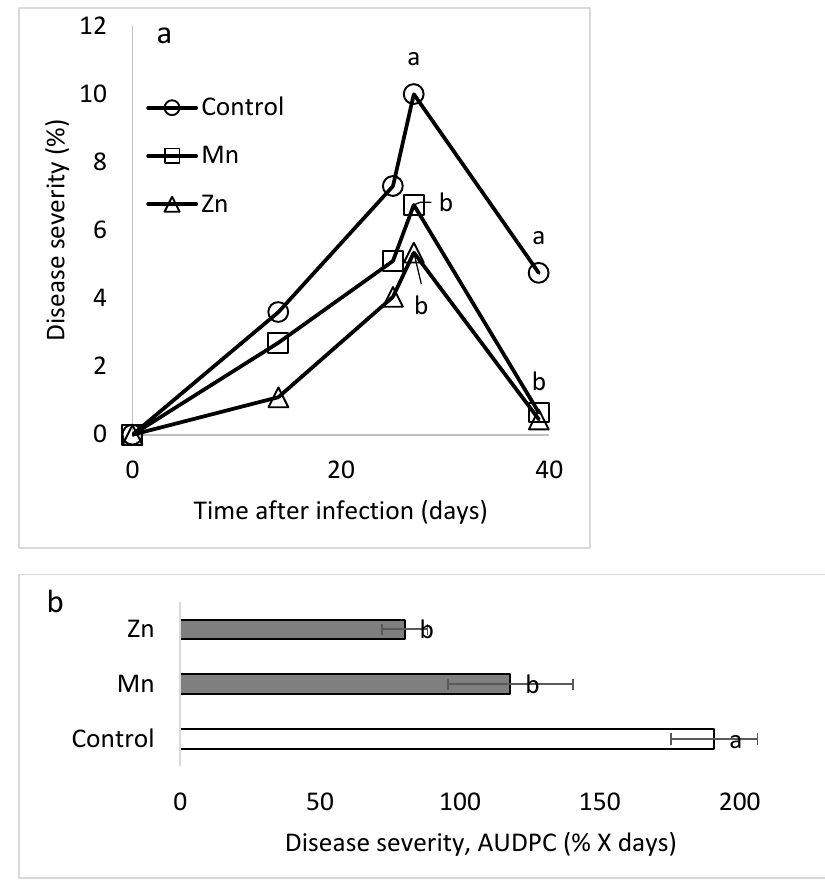
Figure 4. Effects of foliar applications of individual microelement chelates on the severity of sweet basil downy mildew (SBDM) under semi-commercial conditions. Zn-EDTA (0.006%) and Mn-EDTA (0.014%) were sprayed once a week over a two-month period. ( a ) Development of the disease and ( b ) area under disease severity curve (AUDPC) values through 39 days are presented. SBDM severity was evaluated on a 0–100% scale, in which 0 = healthy plants and 100% = plants completely covered by disease symptoms. Values followed by a different letter are significantly different according to one-way ANOVA with Tukey’s HSD test. Default significance levels were set at p ≤ 0.05. Bar = SE.